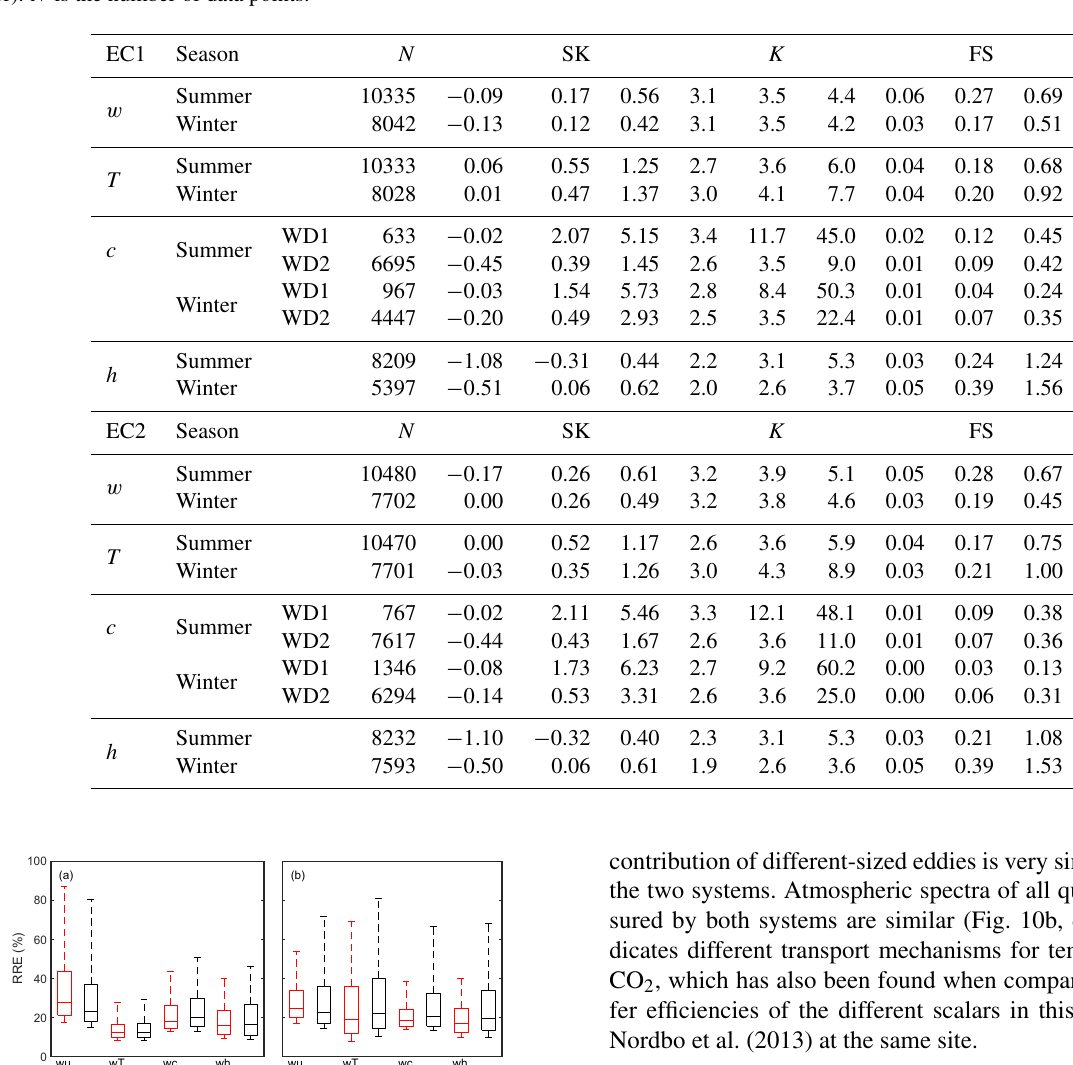
Table 1. Medians and percentile values (10th, 50th and 90th) of skewness (SK), kurtosis ( K ) and flux stationarity (FS) of vertical wind speed ( w ), air temperature ( T ), CO 2 (c) and water vapour ( h ) measured by the two EC setups (EC1 and EC2). Data are separated into summer (June–August) and winter (December–February), and CO 2 statistics are differentiated for wind sectors (WD1: 150–200; WD2: the remaining sector). N is the number of data points.